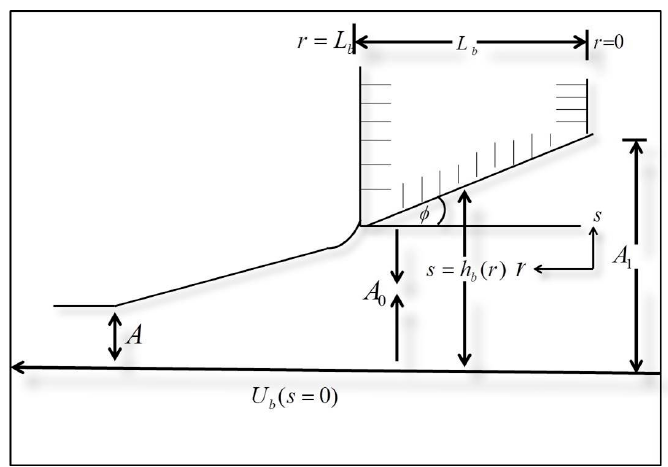
Figure 1. Blade coater geometry.